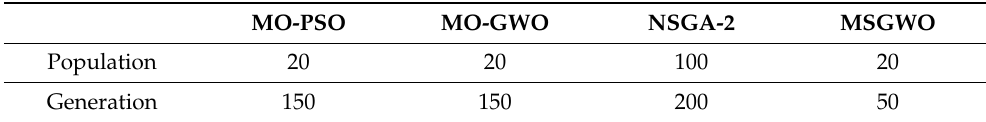
Table 1. Parameters of